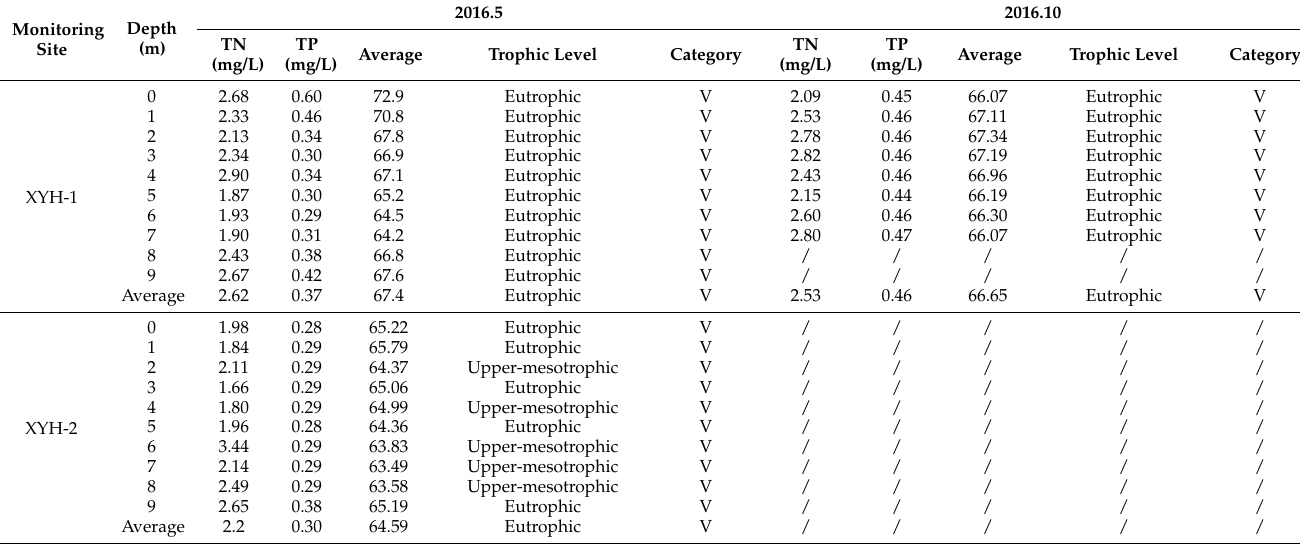
Table 3. The evaluation table of water quality in Lake Xingyun in